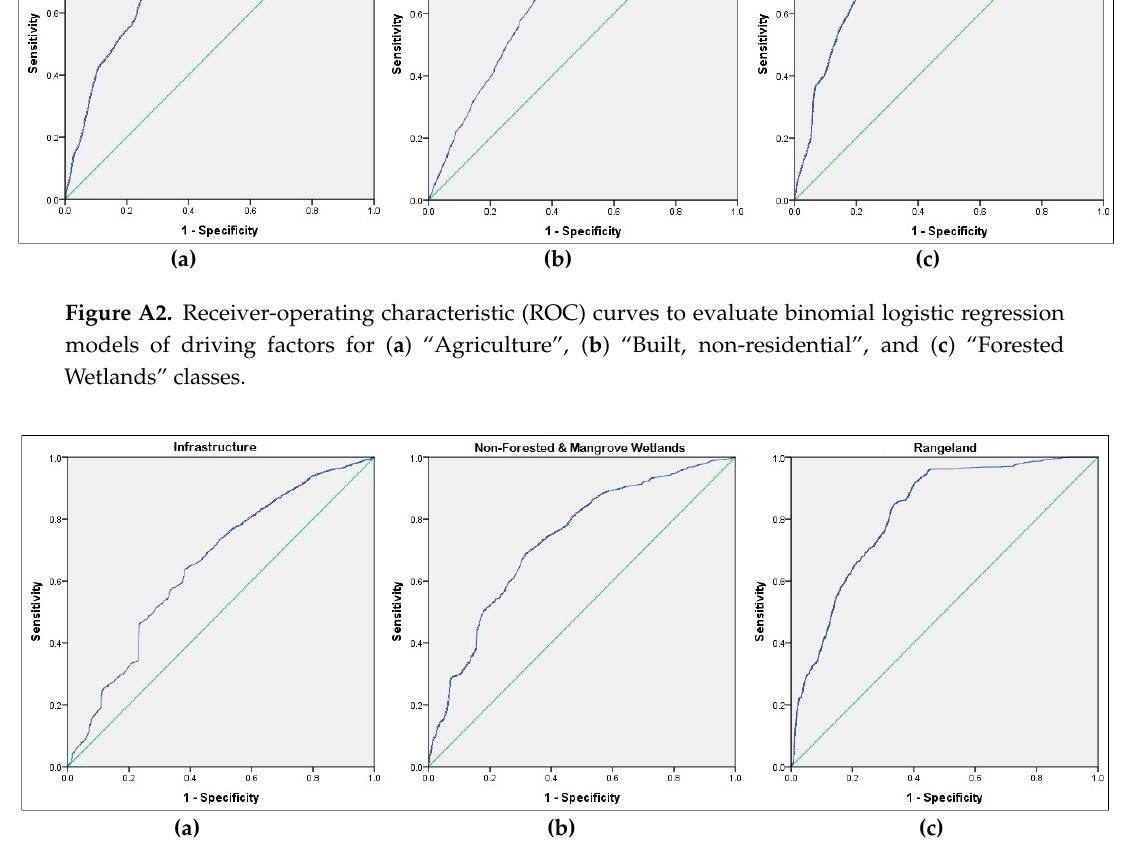
Figure A3. Receiver-operating characteristic (ROC) curves to evaluate binomial logistic regression models of driving factors for ( a ) “Infrastructure”, ( b ) “Non-forested & Mangrove Wetlands”, and ( c ) “Rangeland” classes.